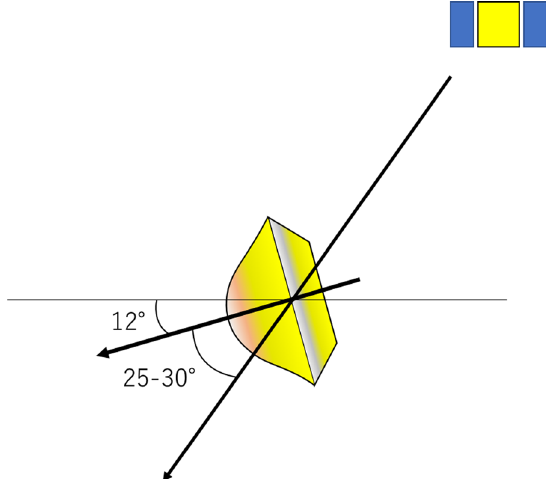
Fig. 19 Schematic view of the capsule observation geometry for ONC-W2 at the time of maximum brightness, based on the planned trajectory information for the capsule and